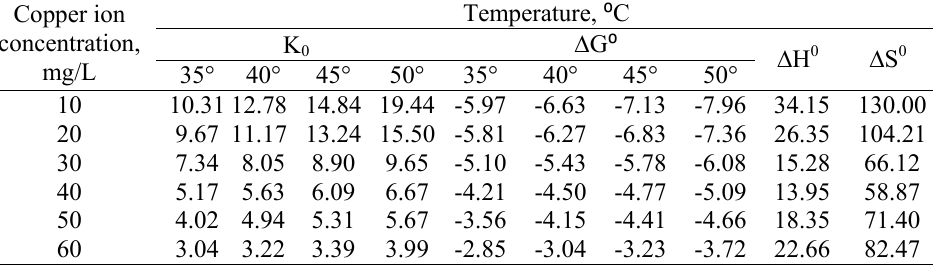
Table 6. Equilibrium constant and thermodynamic parameters for the adsorption of Copper ions by activated CBC Copper ion concentration,